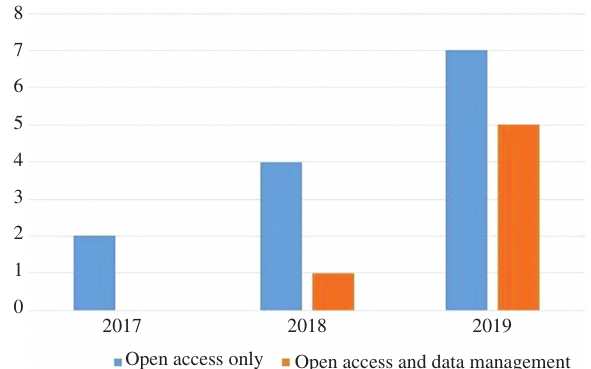
Fig. 3: Number of ongoing projects supported (1 st of December